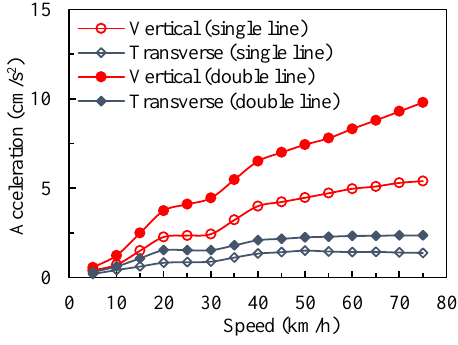
Figure 12. The accelerations of the arch rib at the mid-span .